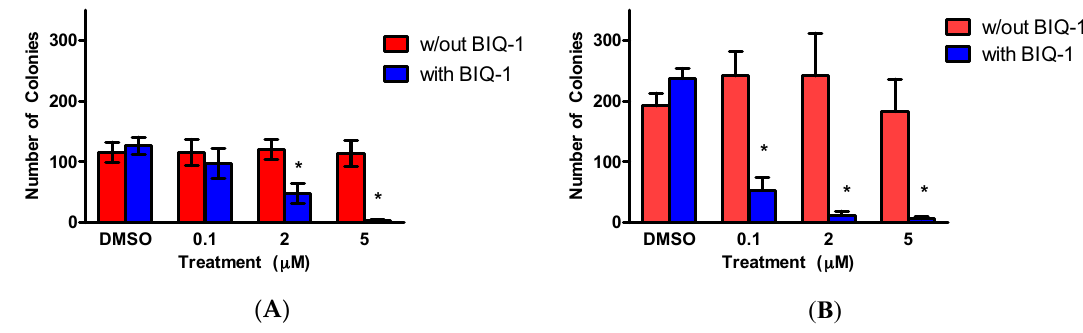
Figure 5. BiQ-1 inhibits clonogenic growth of MOLM-14 ( A ) and THP-1 ( B ) cells. AML cells were treated with BiQ-1 at three concentrations for 24 h and subsequently plated in methylcellulose with or without BiQ-1 at the pre-plating concentrations. Cells grew for 7–12 days prior to termination of the experiment. In the presence of BiQ-1 in the methylcellulose, a significant concentration-dependent reduction in clonogenic growth was observed (* p < 0.05) compared to vehicle (DMSO) control. Clonogenic inhibition was not observed when BiQ-1 was not present in the methylcellulose. The data are representative of two experiments.